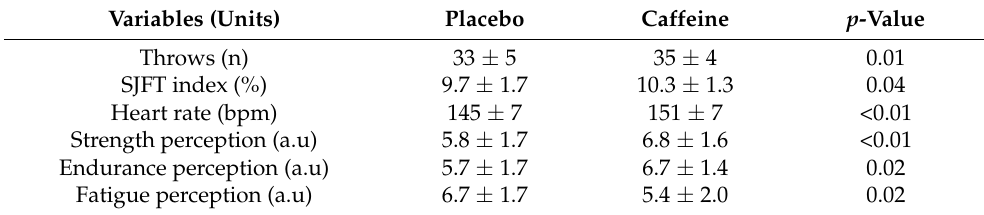
Table 1. Total number of throws, work index, heart rate and perceptual variables obtained after the SJFT test with the administration of 3 mg/kg body mass of caffeine and placebo.